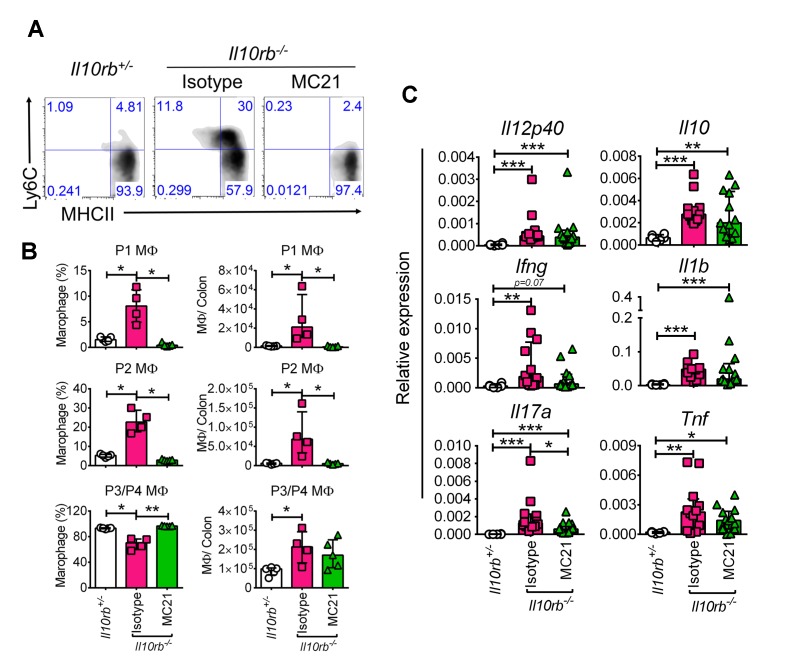
CCR2 blocking does not inhibit inflammatory gene expression in the infant Il10rb-/- mice.(A) Flow cytometry analyses of colonic lamina propria macrophages of indicated mice after 5 days of treatment (20μg/mouse/day, i.p.) with anti-CCR2 (MC21) or rat IgG2b, κ (isotype). (B) Graphical summary of the frequency and numbers of colonic LP macrophage subsets gated on CD45+CD11b+CD11cintCD103-CD64+ cells. (C) Graphical summary of gene expression by qRT-PCR from the colons of mice indicated above. *p<0.05, **p<0.01, ***p<0.001, Mann-Whitney U test. Data shows Median + IQR, each data point indicates individual mouse.